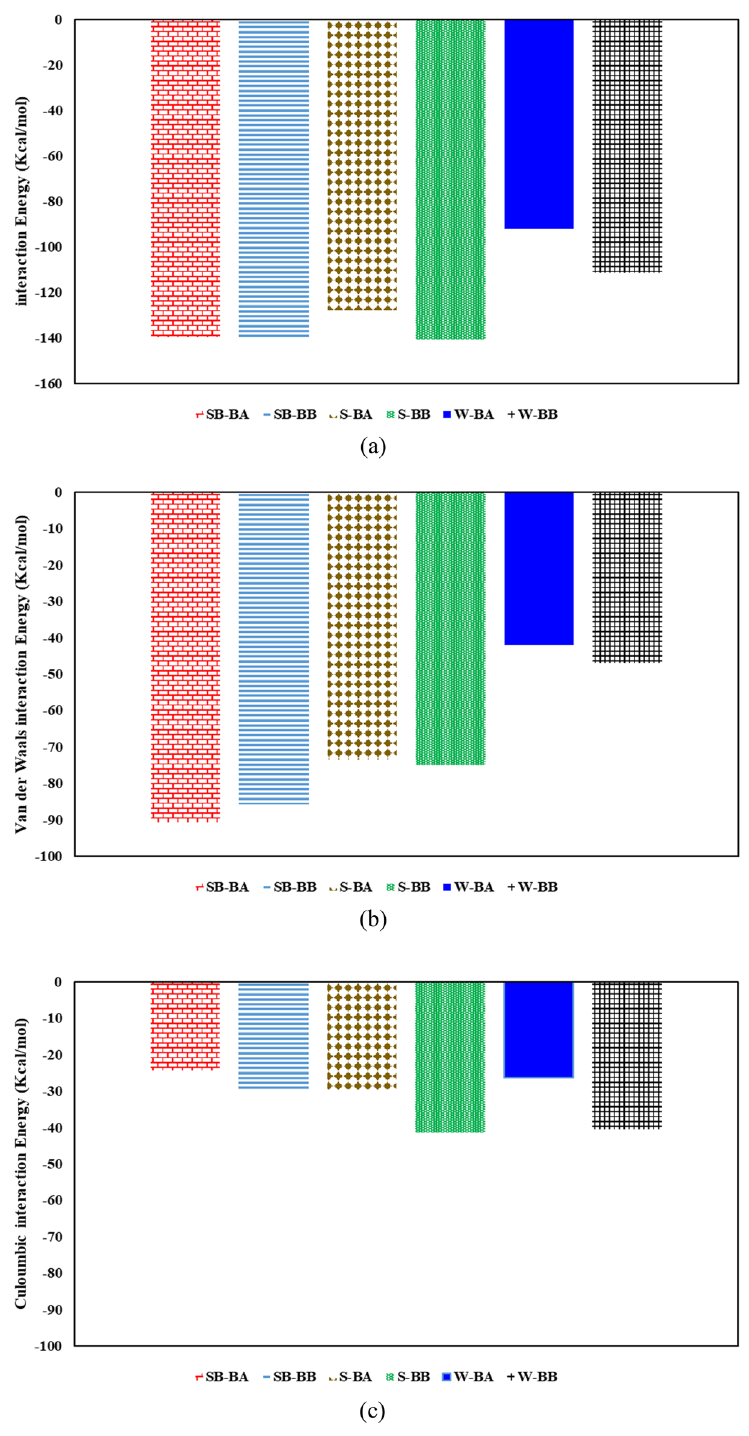
Figure 17. Interaction energy between surfactant molecules and bitumen containing archipelago asphaltenes: ( a ) total interaction energy, ( b ) van der Waals interactions, and ( c ) Coulomb